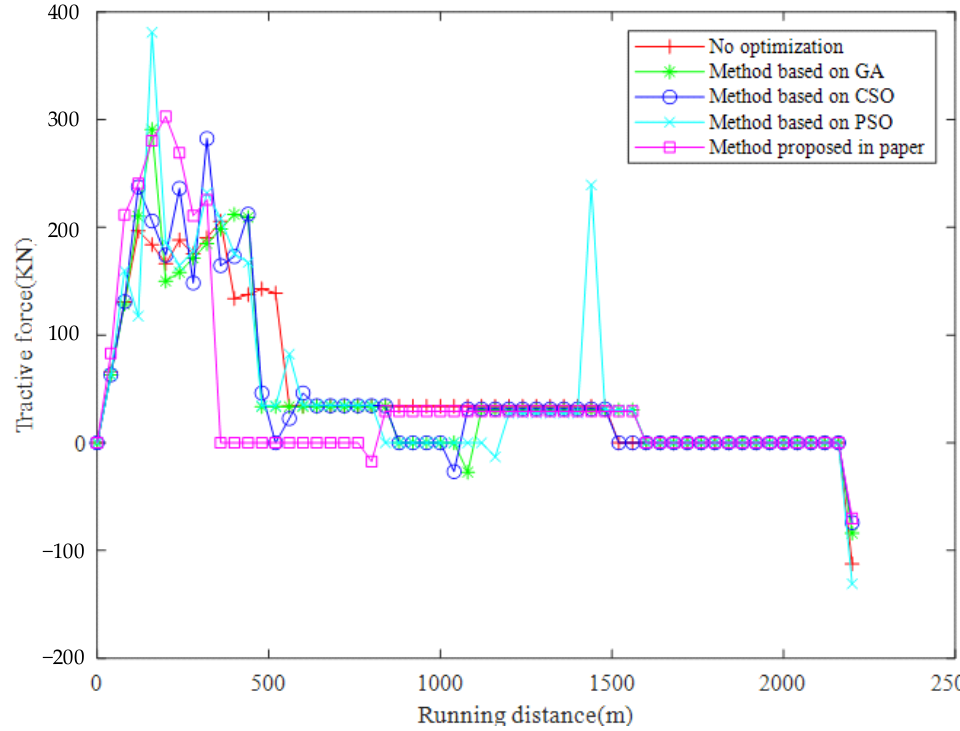
Figure 4. Running distance and running acceleration.